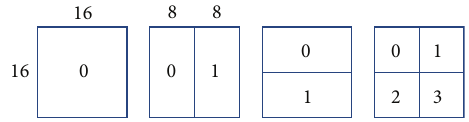
Figure 1: Macroblock partitions: 16 × 16, 8 × 16, 16 × 8, or 8 × 8.